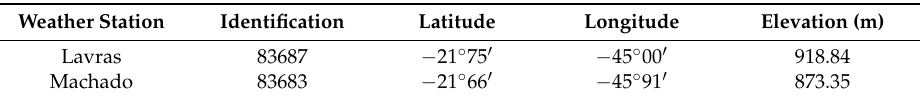
Table 2. Location of weather